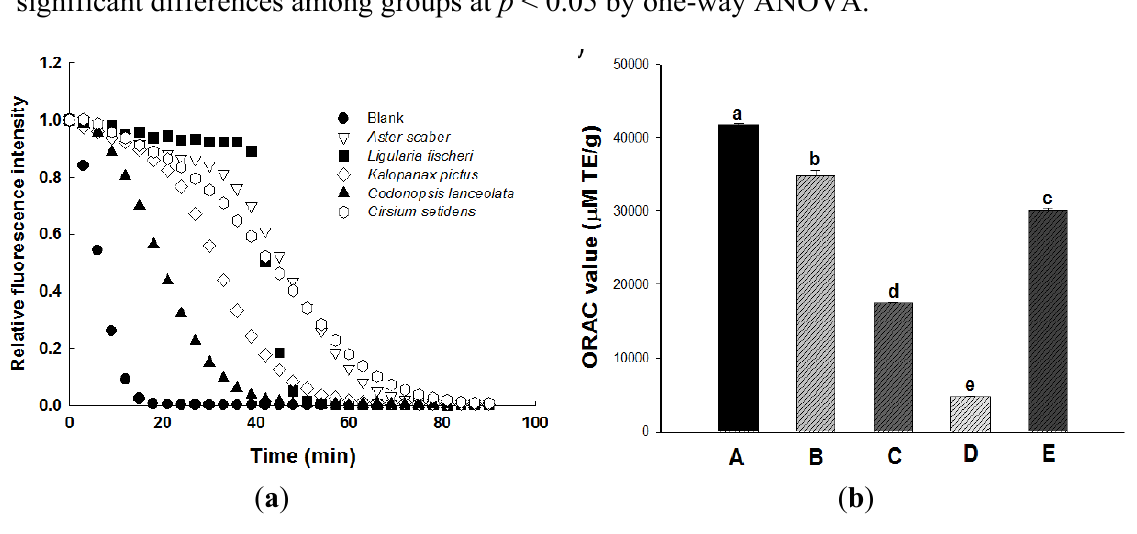
Figure 2. Radical scavenging activity of wild herb extracts as measured by ORAC. ( a ) Decay curve of fl uorescence in the presence or absence of samples. ( b ) Radical scavenging activity of wild herb extracts expressed as Trolox equivalents. A, Aster scaber ; B, Ligularia fischeri ; C, Kalopanax pictus ; D, Codonopsis lanceolata ; E, Cirsium setidens . All values are presented as the means ± SD. Bars with different letters indicate statistically significant differences among groups at p < 0.05 by one-way